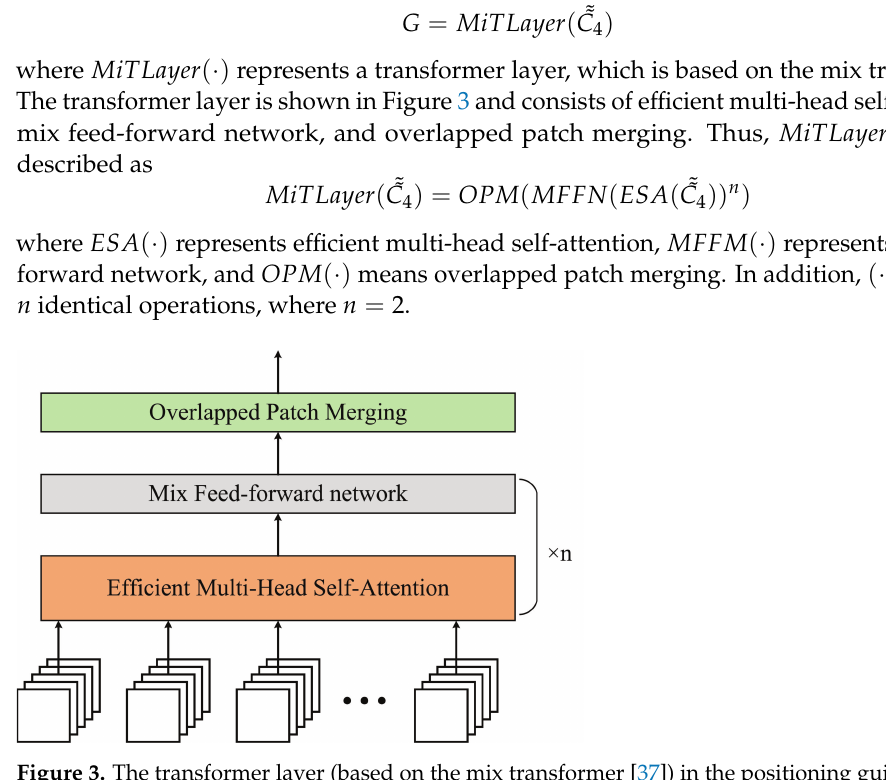
Figure 3. The transformer layer (based on the mix transformer [37]) in the positioning guide